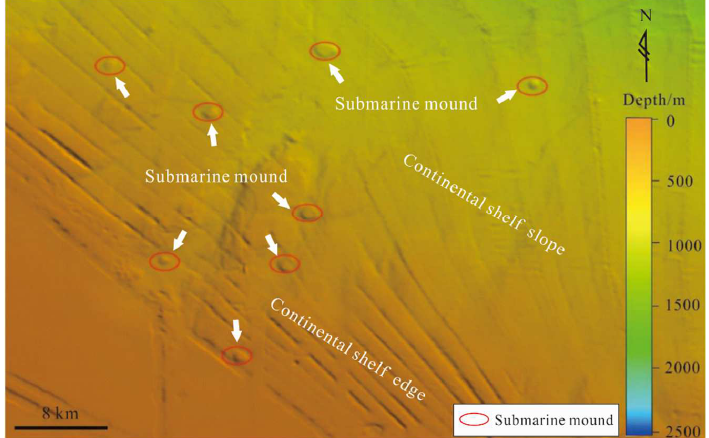
Figure 3. Submarine mounds shown by multibeam image at the continental-shelf edge to the shelf slope of the southern South China Sea from Huang et al., [8]. The red circles indicate where the submarine mounds are located and the area of Figure 3 is shown in Figure 1 as the location of B with a blue-dotted frame.